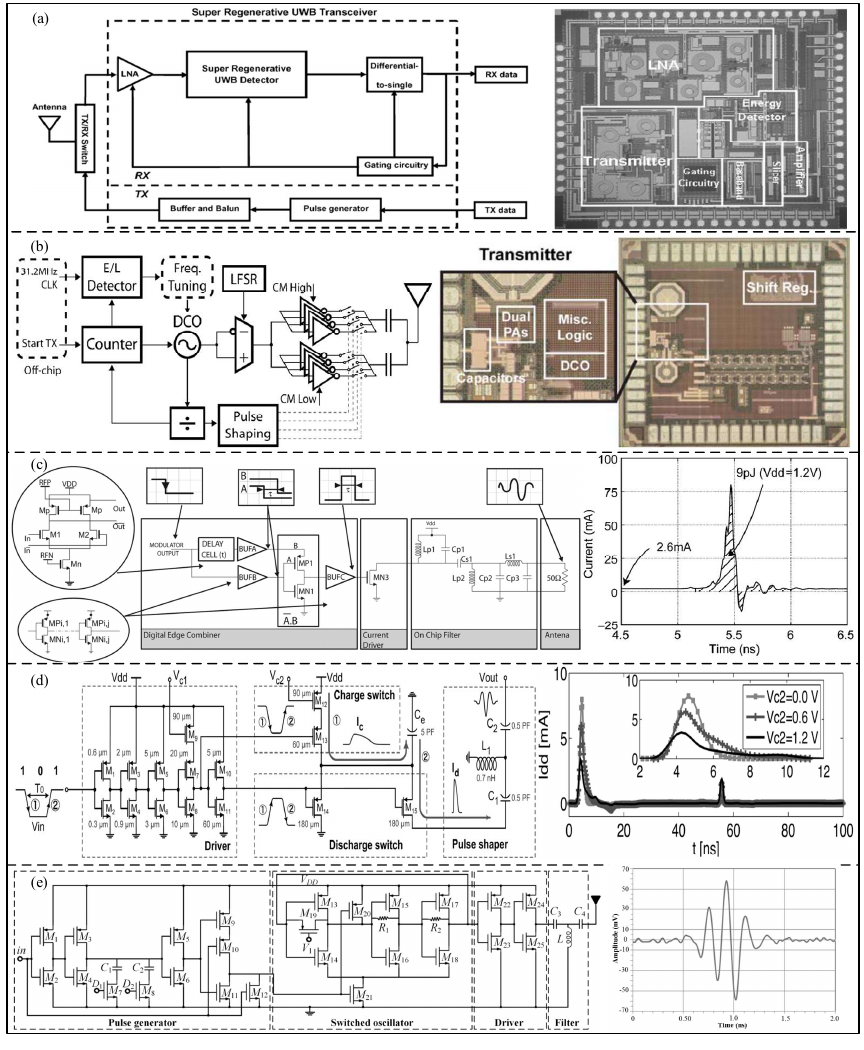
Figure 7. ( a ) Block diagram and die photograph of the super−regenerative UWB transceiver. (Re- printed from [46], Copyright 2014, with permission from IEEE). ( b ) Block diagram and die photo- graph of the proposed generator. (Reprinted from [47], Copyright 2009, with permission from